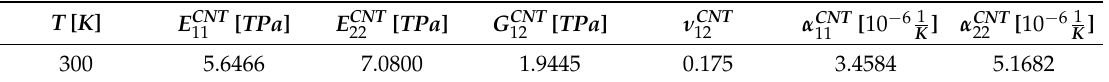
Table 2. Thermo-mechanical properties of (10, 10) armchair single-walled carbon nanotube